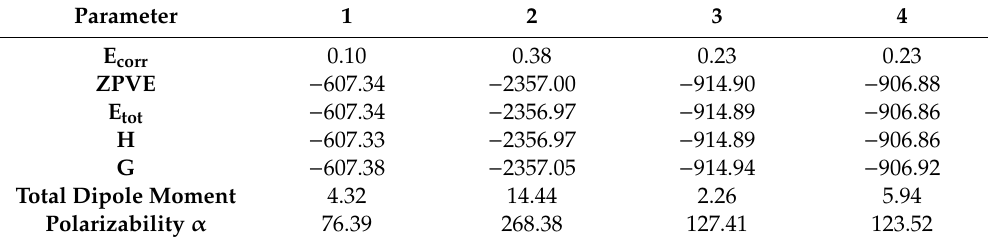
Table 1. Thermal parameters (Hartree/Particle), polarizability α (Bohr 3 ), and dipole moment (Debye) of 1 ‒ 4 .